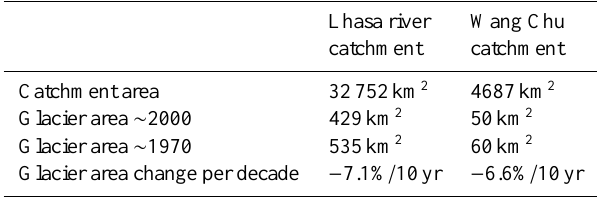
Table 1. Glacier areas and area